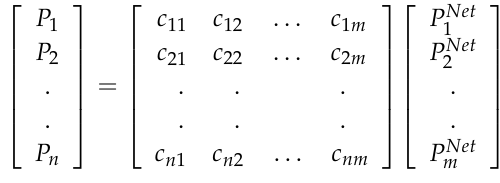
Figure 2. Energy hub model.